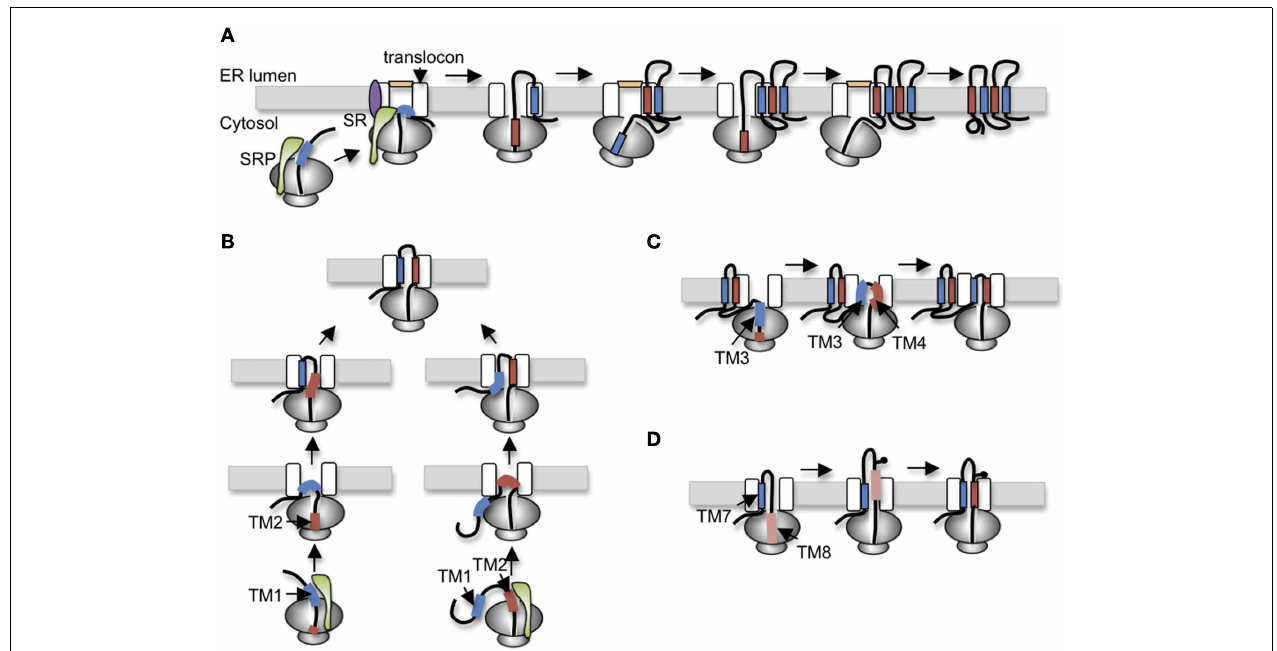
alternate pathways in which translocation is initiated by eitherTM1 (left) or TM2 (right). Most CFTR nascent chains utilized a posttranslational mechanism in whichTM2 insertion dragsTM1 into the translocon. (C) The short loop betweenTM3 andTM4 (five residues) suggests thatTM3 andTM4 simultaneously insert into the translocon as a helical hairpin. A similar mechanism is also proposed forTM5-6,TM9-10, andTM11-12. (D) Stop transfer activity ofTM8 is weakened by Asp924 which results in transient exposure ofTM8 in the ER lumen before acquiring its final membrane spanning